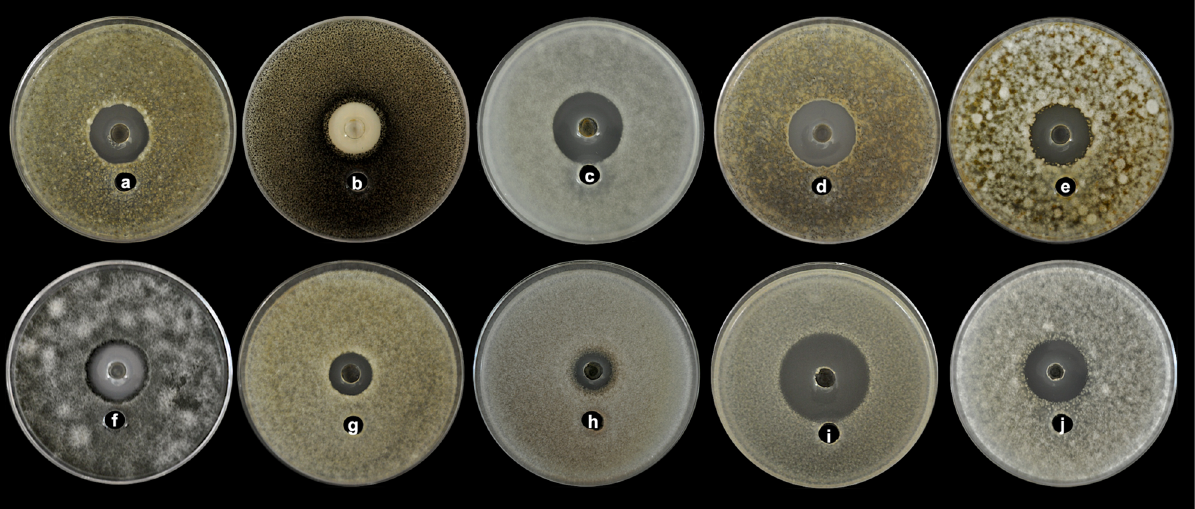
Figure 5. Antifungal activity of CL 84 by agar well diffusion showing broad spectrum against different phytopathogens ( a ) Aschochyta sp., ( b ) Colletorichum acutatum , ( c ) Colletotrichum gloeosporioides ATCC 42374, ( d ) Colletotrichum gloeosporioides , ( e ) Colletotrichum capsici , ( f ) Curvularia clavata , ( g ) Fusarium nivale , ( h ) Fusarium solani , ( i ) Moniliophthora roreri , ( j ) Pestalotiopsis maculans. The CL 84 formed stable emulsions with burnt motor oil, motor oil, n -hexadecane, xylene, toluene, n -hexane and crude oil (Figure 6 and Table 6). The gas oil was the only hydrocarbon not efficiently emulsified, whereas burnt motor oil and crude oil were the best emulsified substrates. Table 6. Emulsifying activity EI 24 (%) of CL 84 produces by Bacillus subtilis subsp . spizizenii MC6B-22 in presence of different hydrophobic substrates.